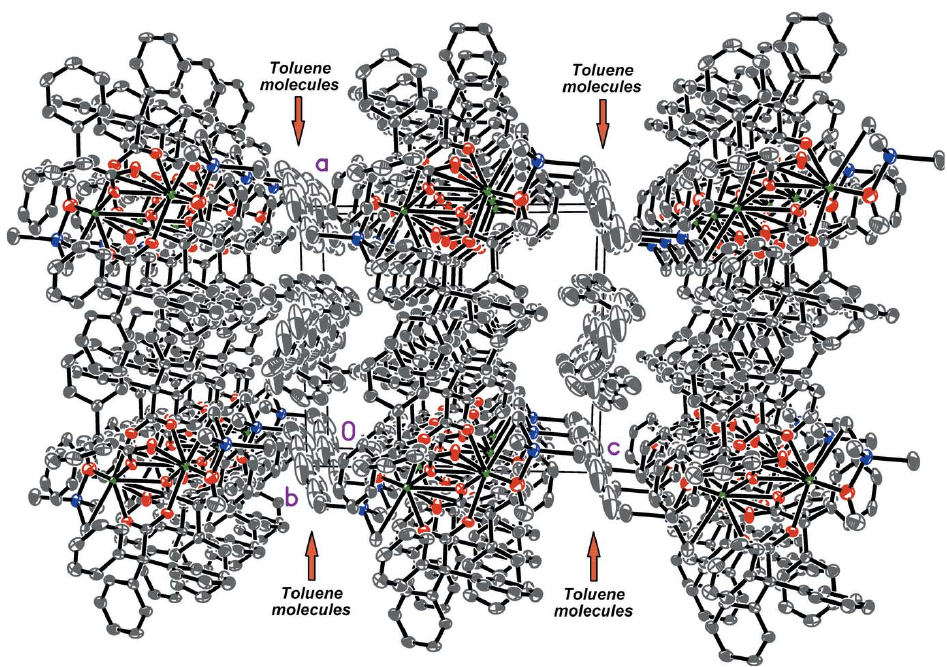
Figure 4 Aview along the b axis of the crystal packing of the title compound. Displacement ellipsoids are drawn at the 50% probability level. Hydrogen atoms are